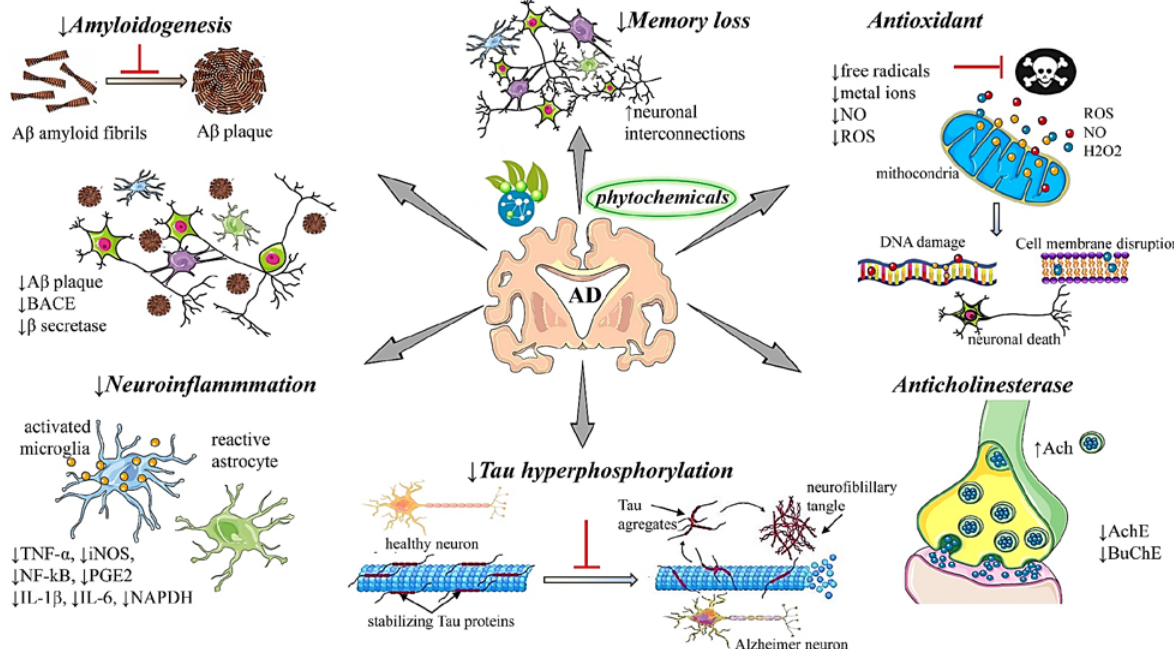
Figure 1. Summarized scheme with the most representative neuroprotective mechanisms of actions and effects of phytochemicals in Alzheimer’s disease. Abbreviations and symbols: ↑ increase, ↓ decrease, acetylcholine. (ACh), acetylcholinesterase (AchE), amyloid beta (A β ), beta-site amyloid precursor protein cleaving enzyme 1 (BACE1), butyrylcholinesterase (BuChE), inducible nitric oxide synthase (iNOS), tumor necrosis factor (TNF)- α, interleukin (IL), nitric oxide (NO), nuclear factor kappa-light-chain-enhancer of activated B cells (NF-kB), Prostaglandin E 2 (PGE2), nicotinamide adenine dinucleotide phosphate. (NADPH), reactive oxygen species (ROS), tumor necrosis factor-alpha (TNF- α).